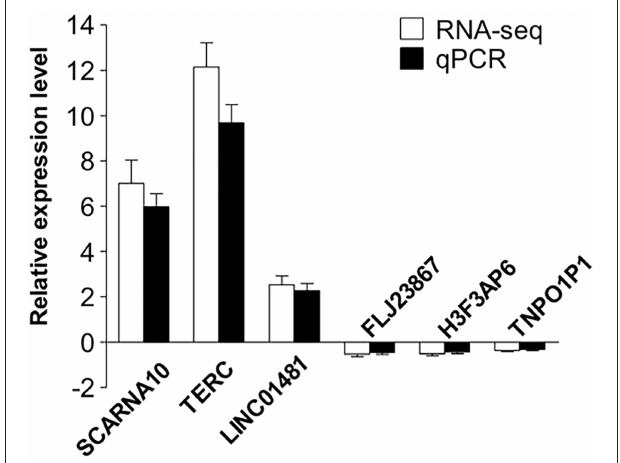
FIGURE 4 | Validation of the selected LncRNAs. The verification of 6 randomly selected LncRNAs from IS patients and healthy controls by quantitative real-time PCR (qRT-PCR). Column heights represent mean fold changes in expression of the IS group. The trends in the expression of randomly selected LncRNAs detected by qRT-PCR ( p < 0.05 vs. control) were similar to those detected by